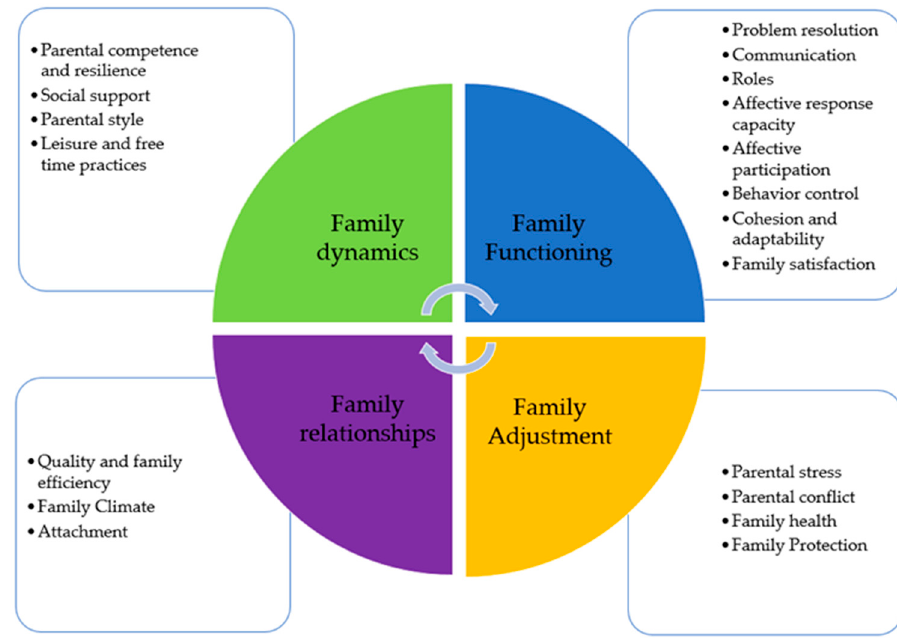
Figure 2. Family variables measured by the instruments.